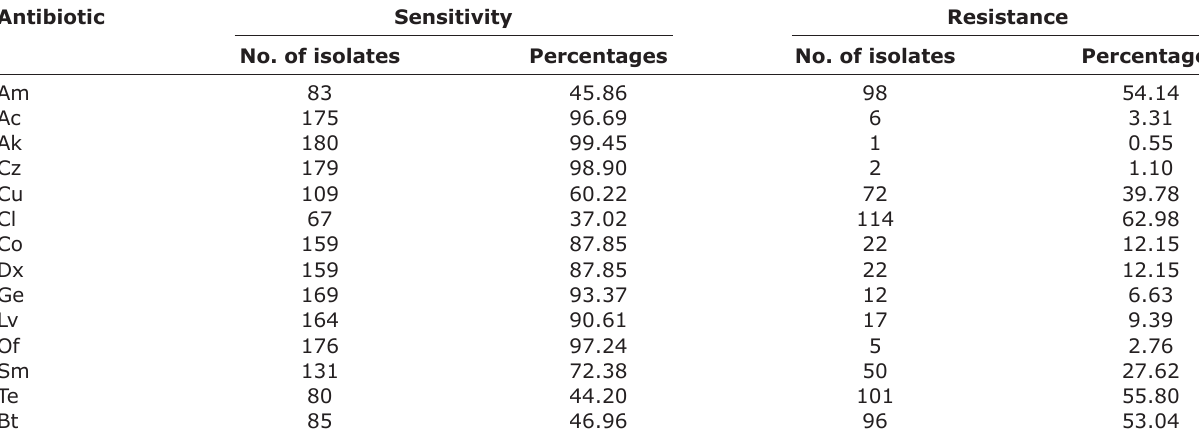
Table-4: The antibiotic resistance of Salmonella isolated in the poultry farms and households (n=181).